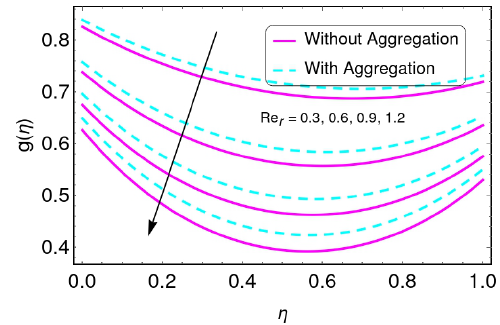
Figure 11. The results of Re r on g ( η )